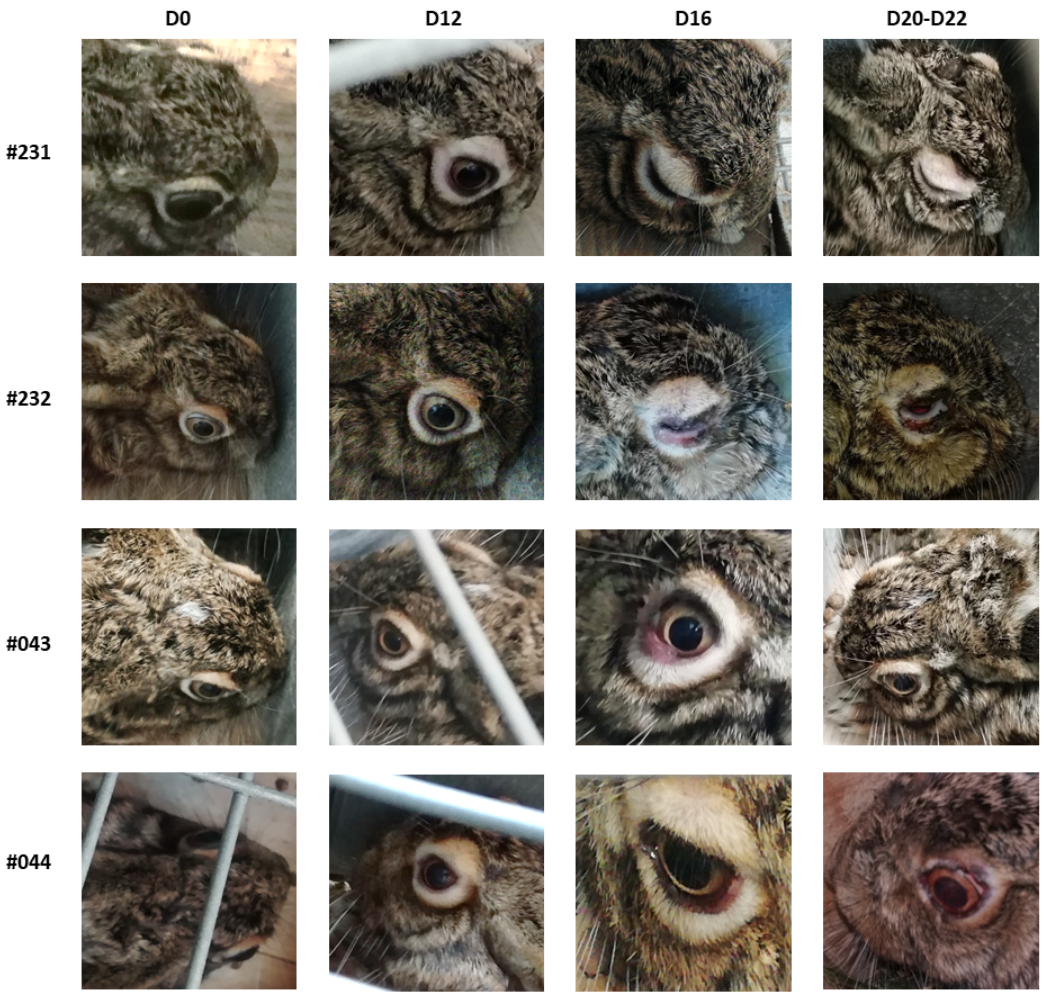
Figure 3. Clinical signs of myxomatosis of four hares involved in the study. Hares #231 and #232 (H-G1) were not vaccinated. Hares #043 and #044 belonged to the H-G3 group (vaccinated with 2.90 × 10 5 ffu dose of Mixohipra-FSA). D-day after challenge. Hares #233 (from H-G1, not vaccinated), #078 (from H-G2, vaccinated with low dose